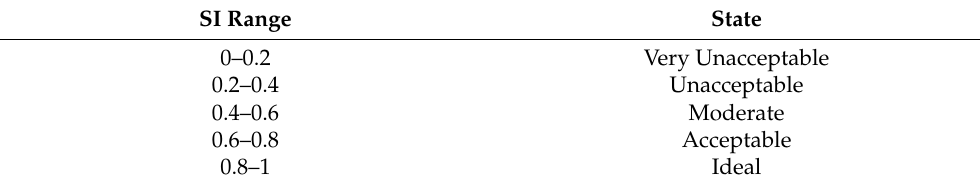
Table 2. Sustainability Index Range